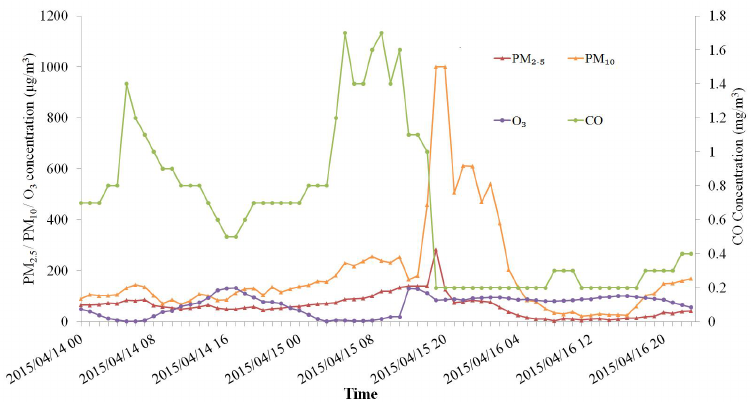
Figure 1. Hourly variations of PM 2.5 , PM 10 , CO, and O 3 concentrations in Dongsi station, Beijing during the dust storm